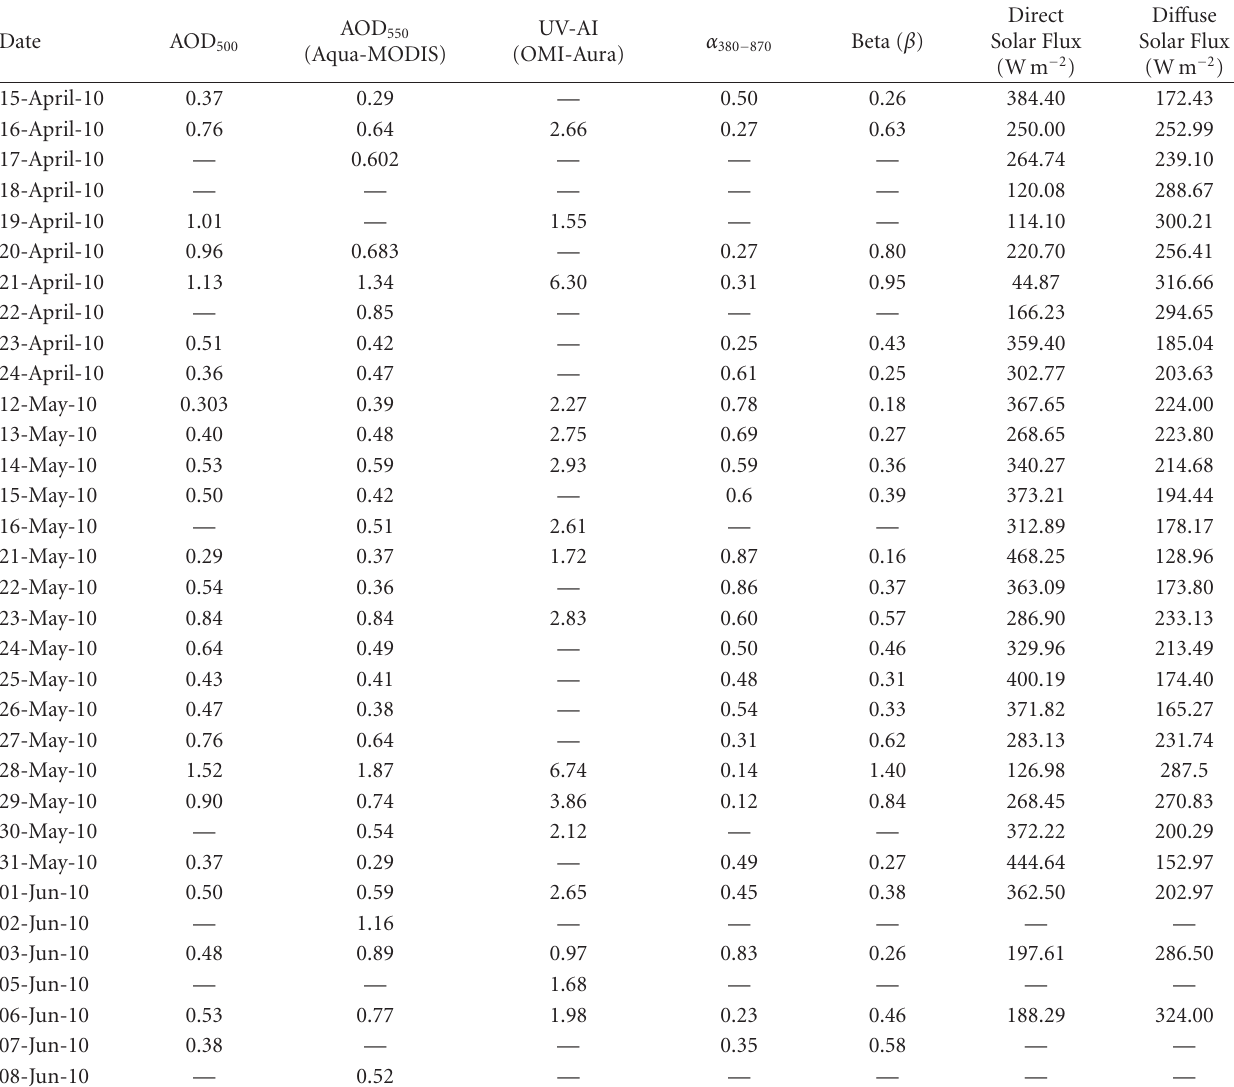
Table 2: Daily mean values of MT and MODIS AOD, OMI-AI, α 380 − 870 , β , direct solar flux, and di ff use solar flux at Patiala during dusty, predusty and postdusty days in the premonsoon season of